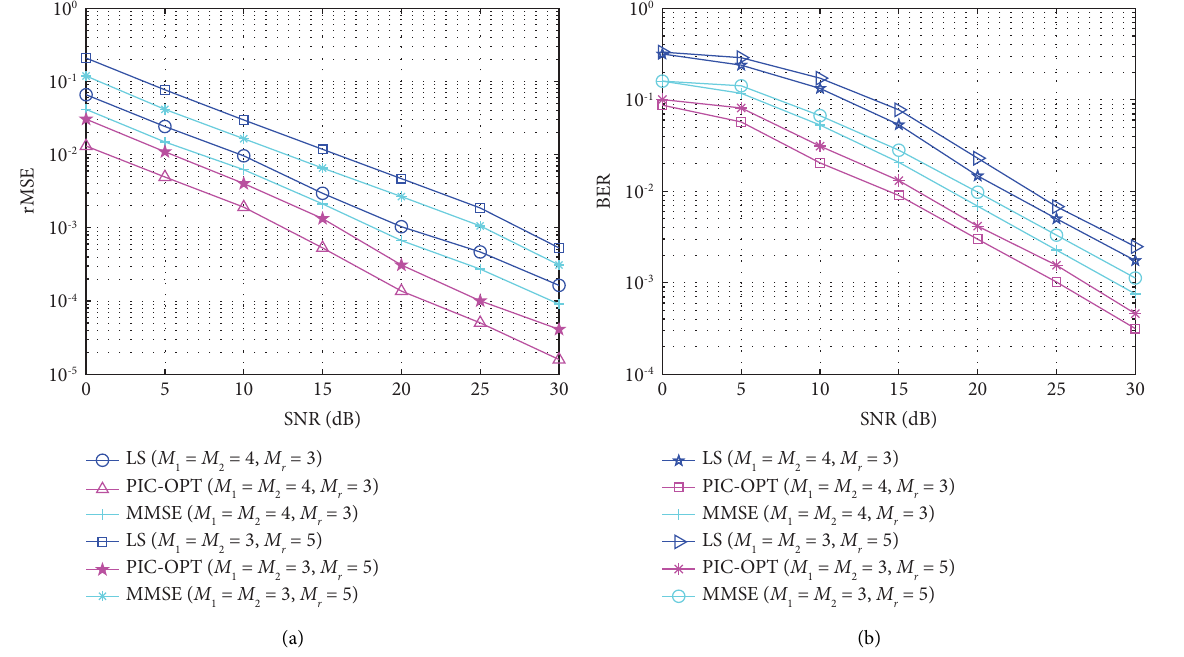
Figure 4: Te rMSE and BER performances of the PIC-OPTalgorithm compared with those of the LS algorithm and the MMSE